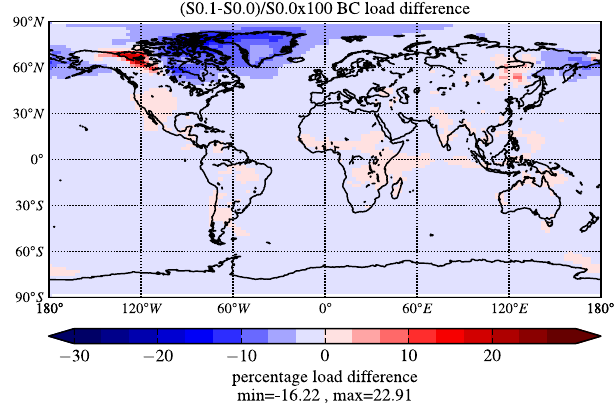
Figure 8. Percentage difference of annual mean computed tropo- spheric load of BC attributed to wildfire emission injection height calculated as (load_S0.1 – load_S0.0) / (load S0.0) × 100. The scale is from − 30 to 30%; the minimum and maximum percentage dif- ferences are printed below the